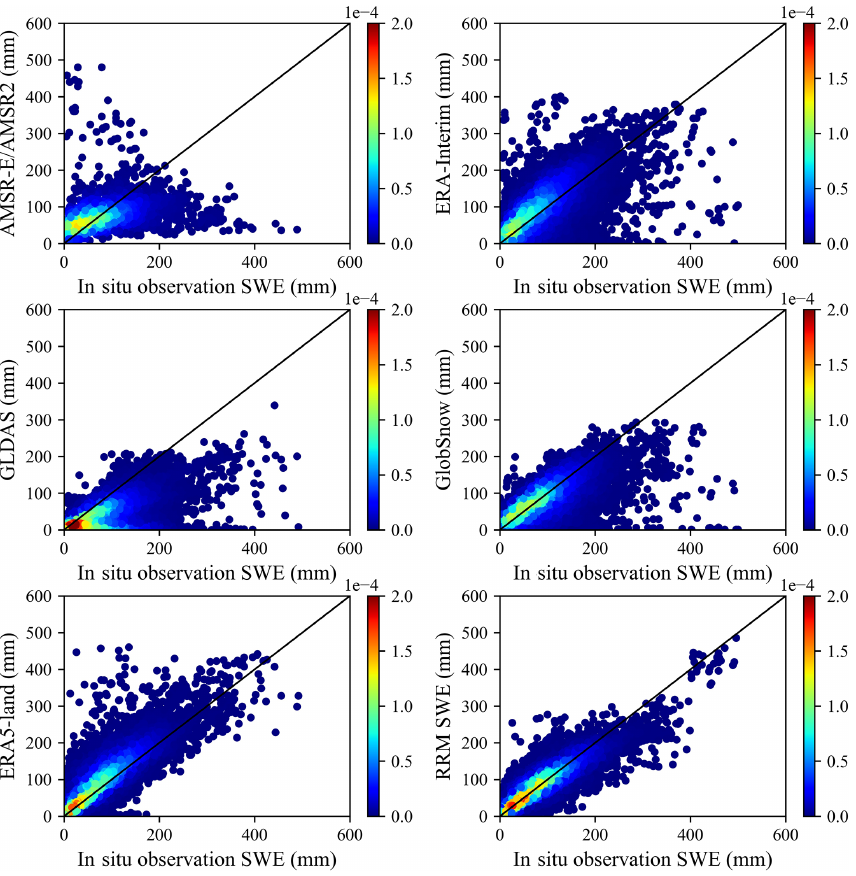
Figure 4. Error verification density diagram (a total of 38807 sample points were used for verification). The color bar represents the value of kernel density estimation. The closer the high-density area is to the 1 : 1 line, the higher the verification accuracy of the dataset is at most of the measuring